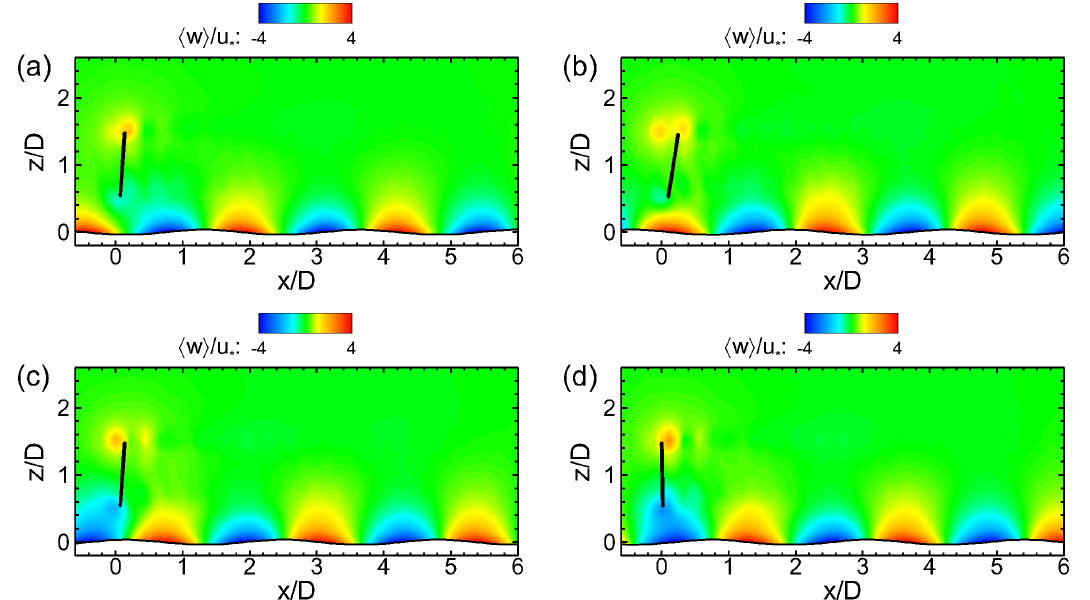
Figure 5. Swell-phase averaged vertical wind velocity (cid:104) w (cid:105) at four representative swell phases for pitching-turbine case: ( a ) trough (Phase 1); ( b ) forward slope (Phase 2); ( c ) crest (Phase 3); and ( d ) backward slope (Phase 4). Turbine-rotor-disk location indicated by thick black